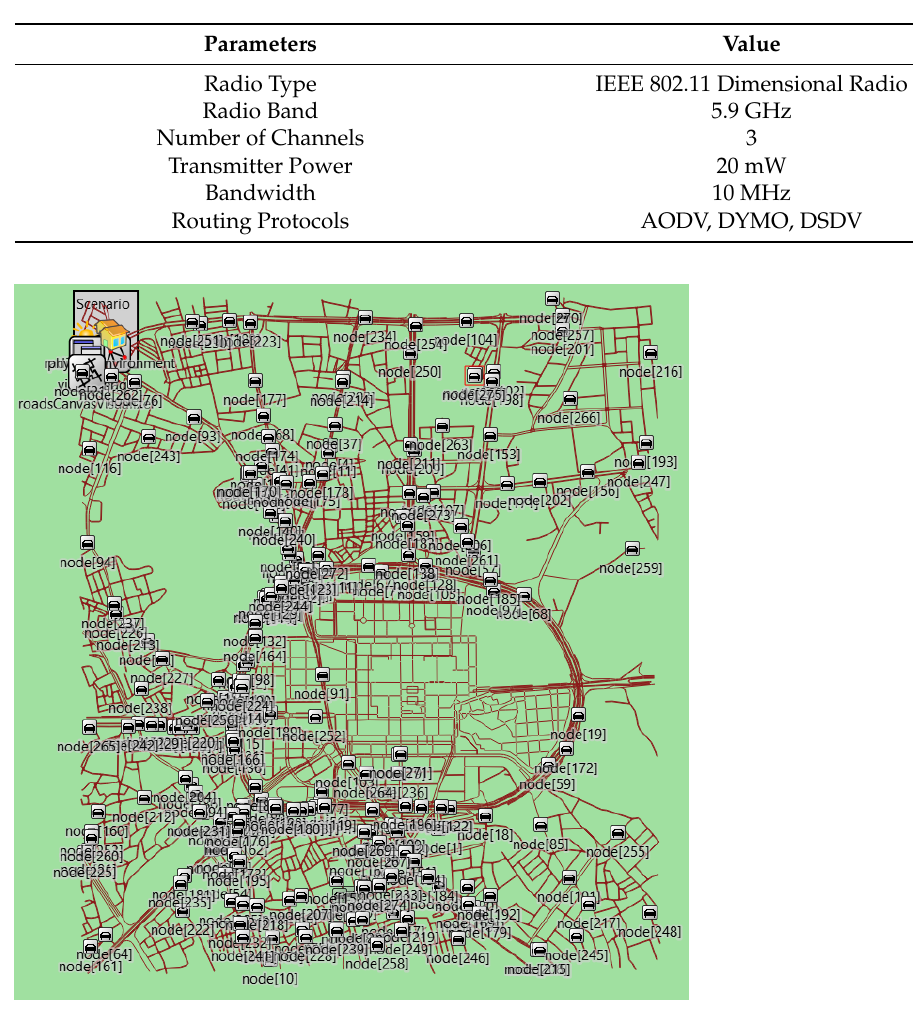
Figure 5. OMNeT++ simulation of the traffic model generated by SUMO.